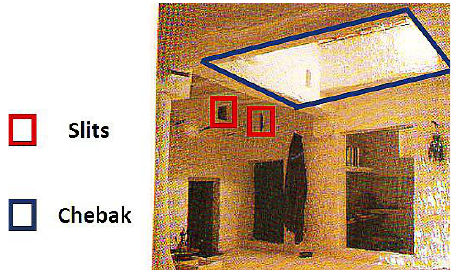
Figure 10. The Amesentidar in the house of the M’zab valley (Ravéreau, 2003)